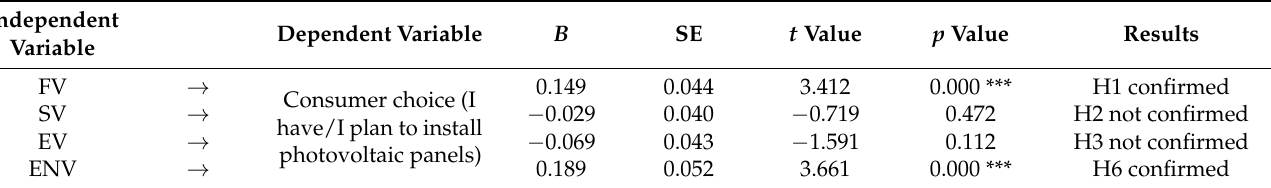
Table 4. Results of the structural equation